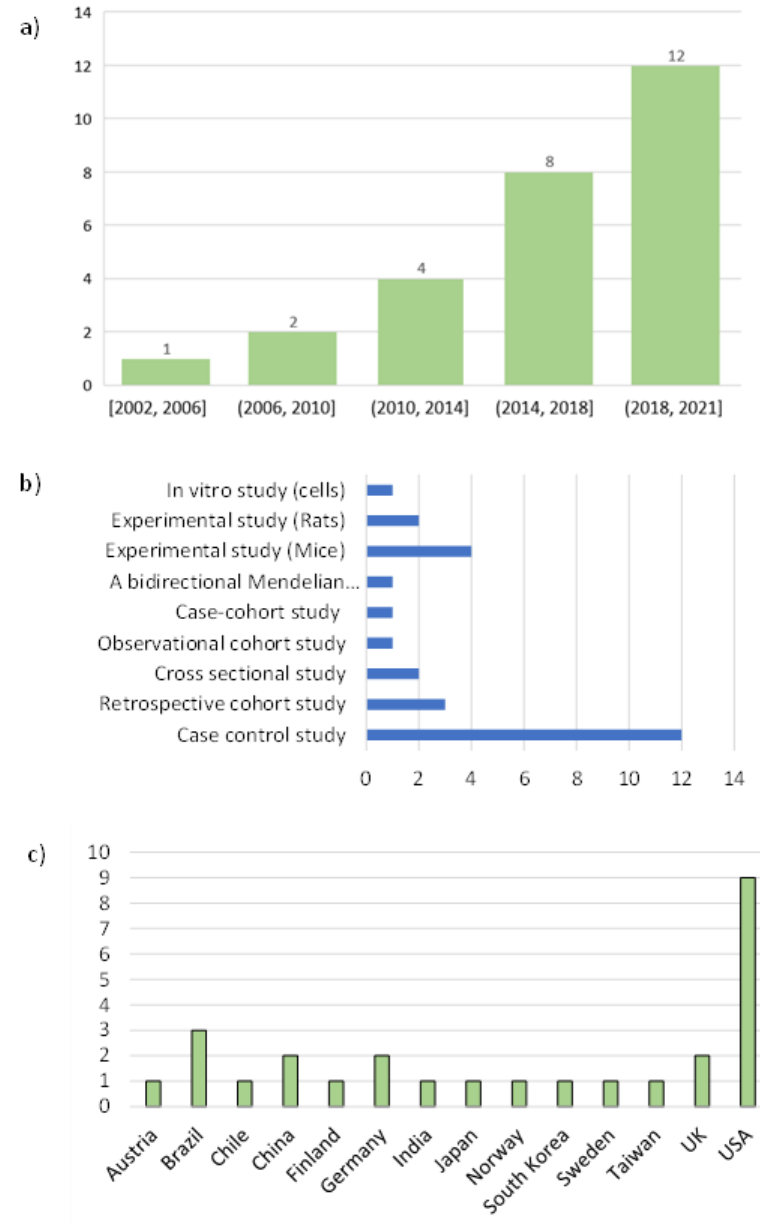
Figure 2. Study characteristics: years of publication ( a ), design, ( b ), research laboratory country ( c